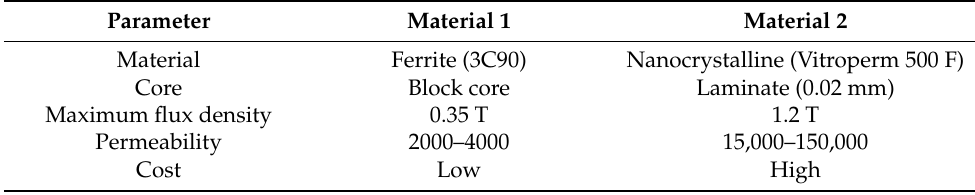
Table 2. Characteristics of ferrites and nanocrystalline alloys for MFT